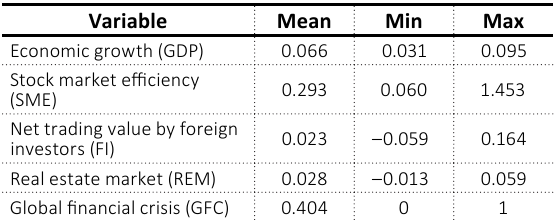
Table 1. Descriptive statistics of all variables